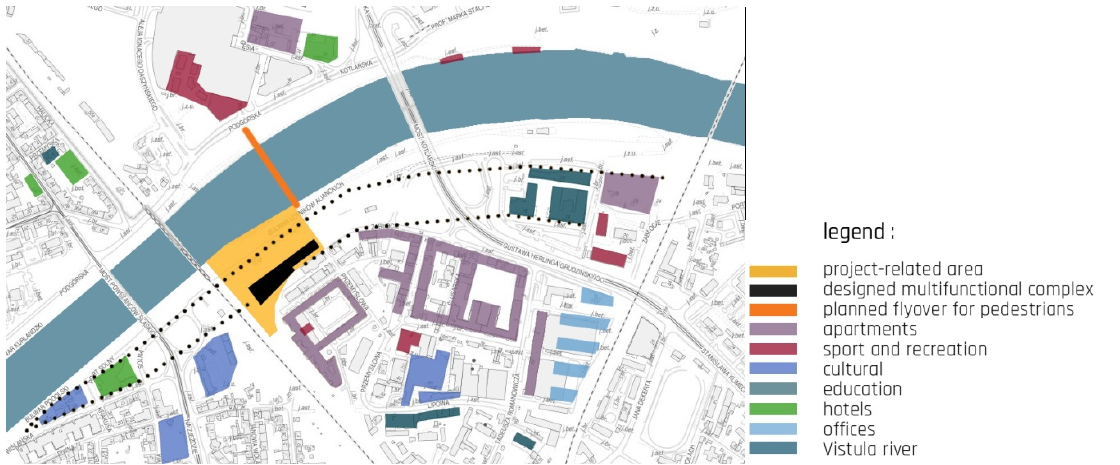
Figure 8. Significant characteristic building development surrounding the study area (elaborated by E.